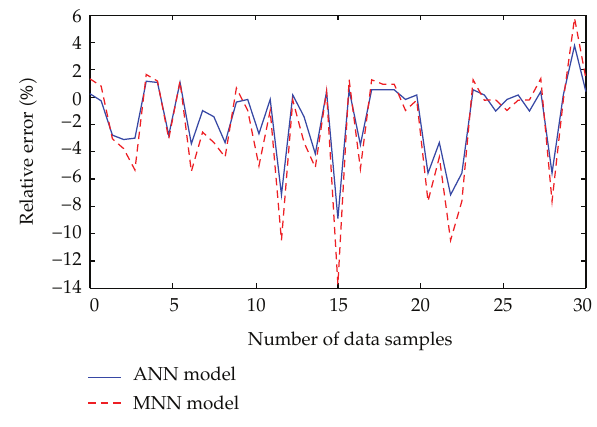
Figure 7: Relative error curve of models.